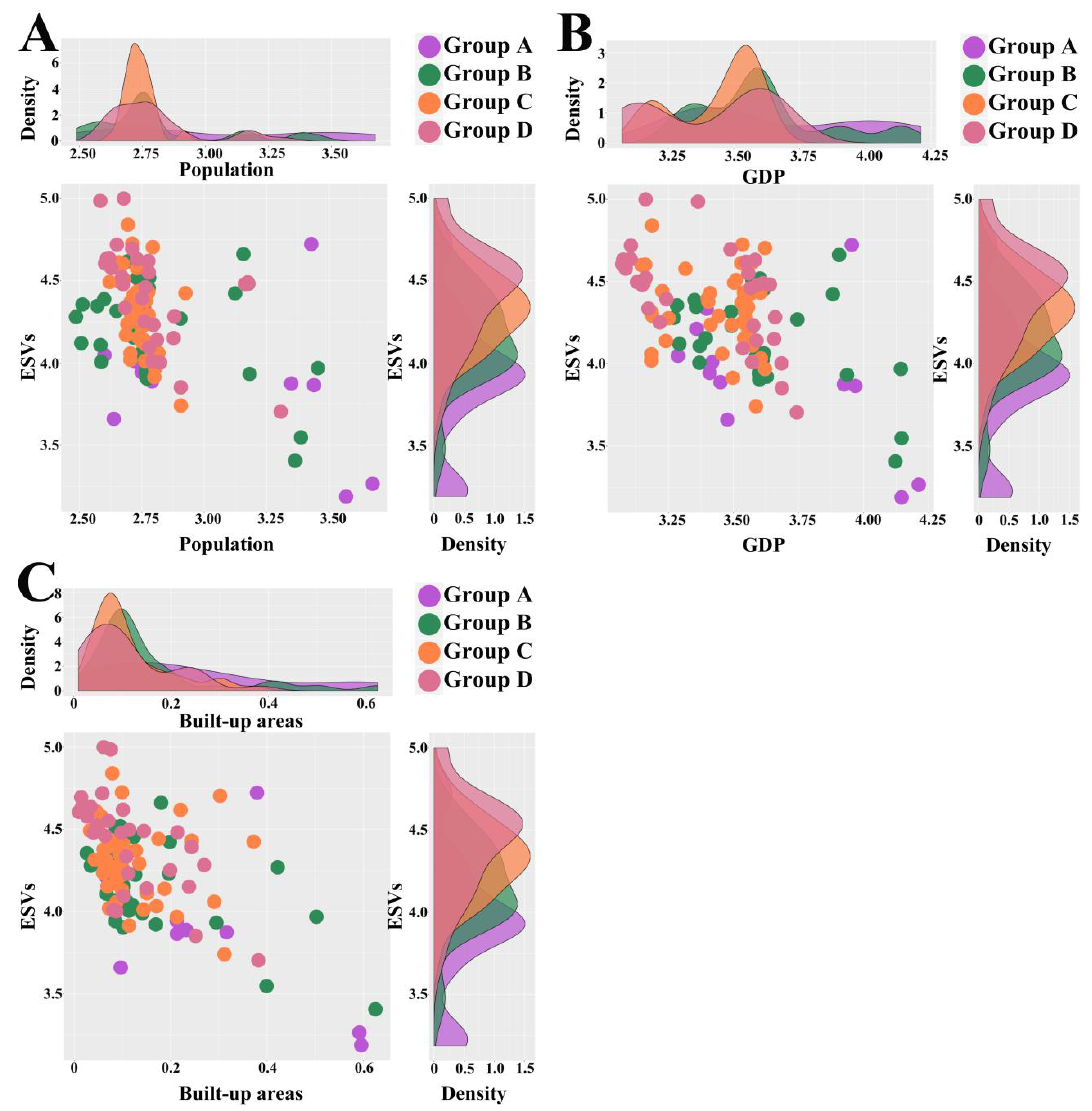
Figure 6. Kernel density estimations between the ESVs and population ( A ), GDP ( B ) and built-up areas ( C ). Note: each dot represents the distribution characteristics of the independent variables and dependent variables of each town in Weifang; the 124 towns were studied, so there were 124 dots in each figure.